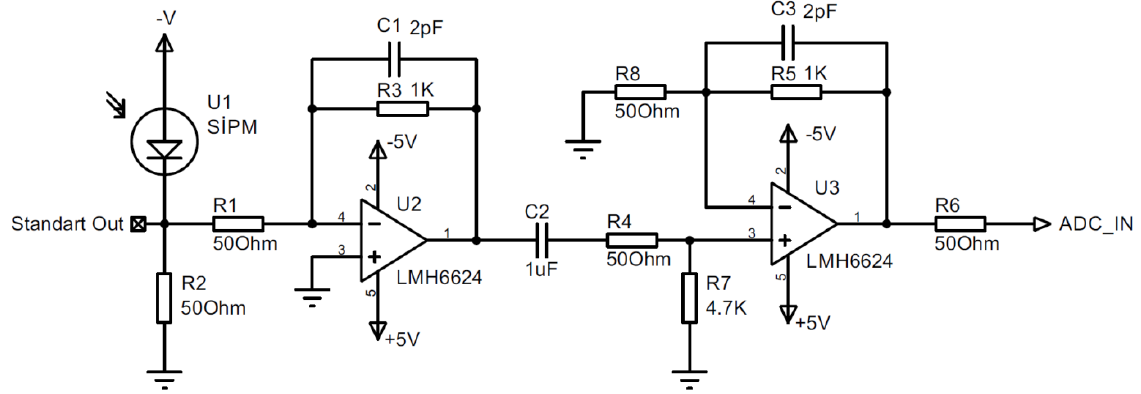
Figure 4. Schematic block circuit of SiPM 2-stages voltage amplifier.